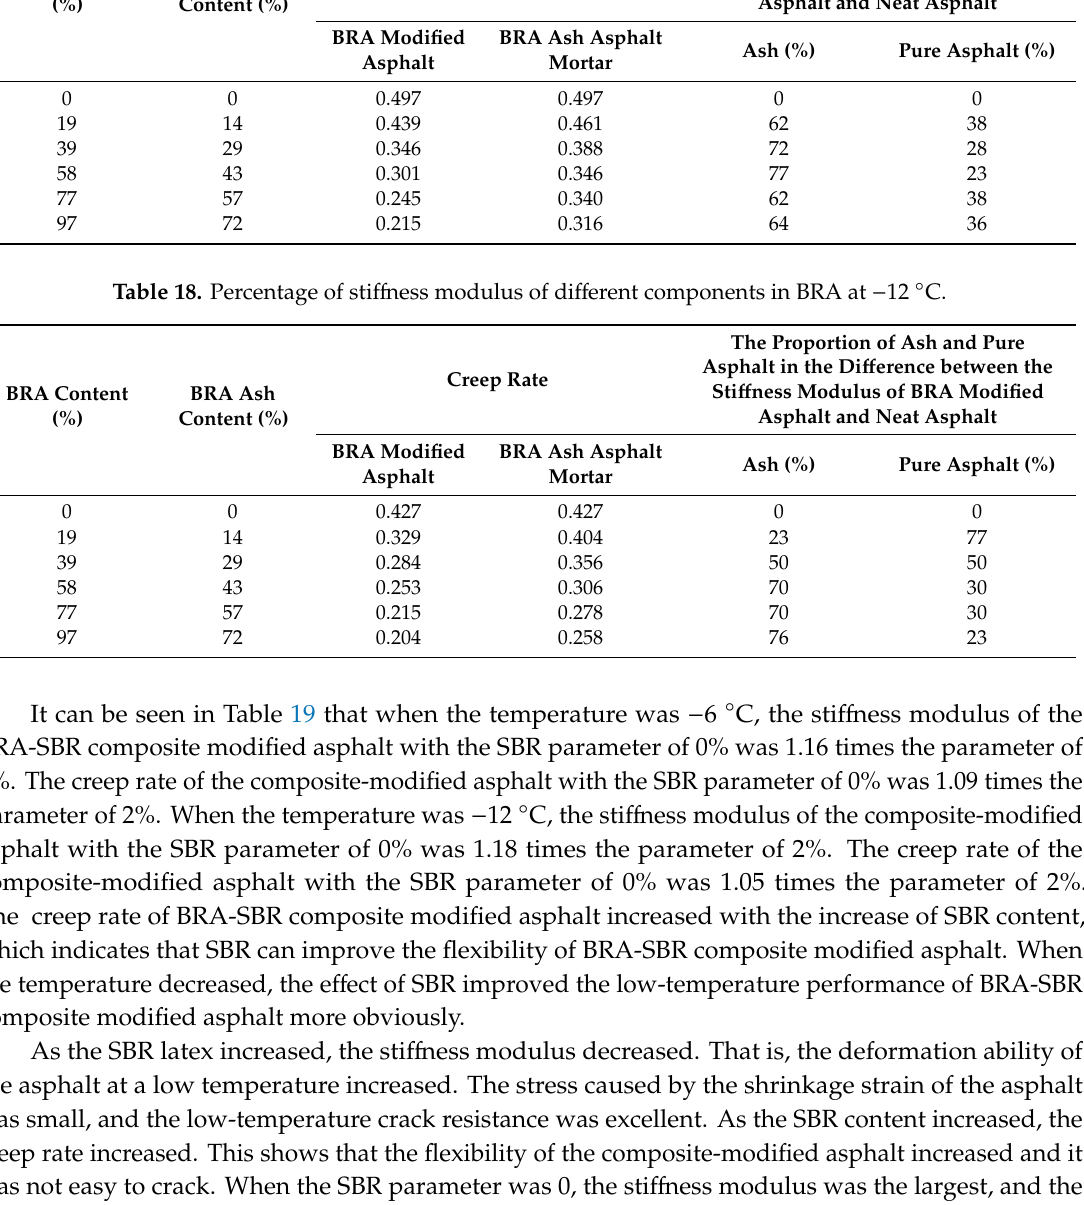
The Proportion of Ash and Pure Asphalt in the Di ff erence between the Sti ff ness Modulus of BRA Modified